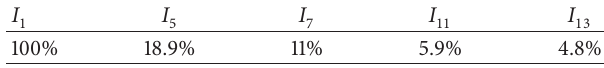
Table 5: Current composition of a nonlinear load.